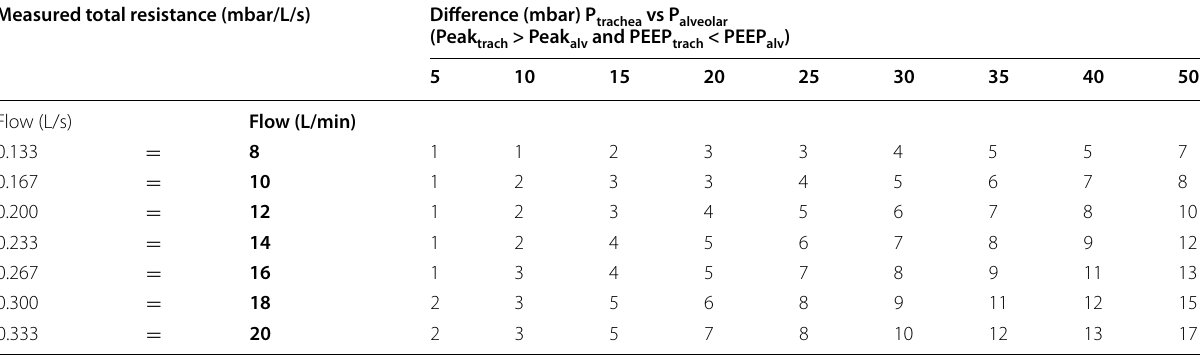
Table 4 Pre-calculated pressure differences between dynamic tracheal and dynamic global alveolar pressures for various set flows and measured resistances, as provided by the manufacturer Measured total resistance